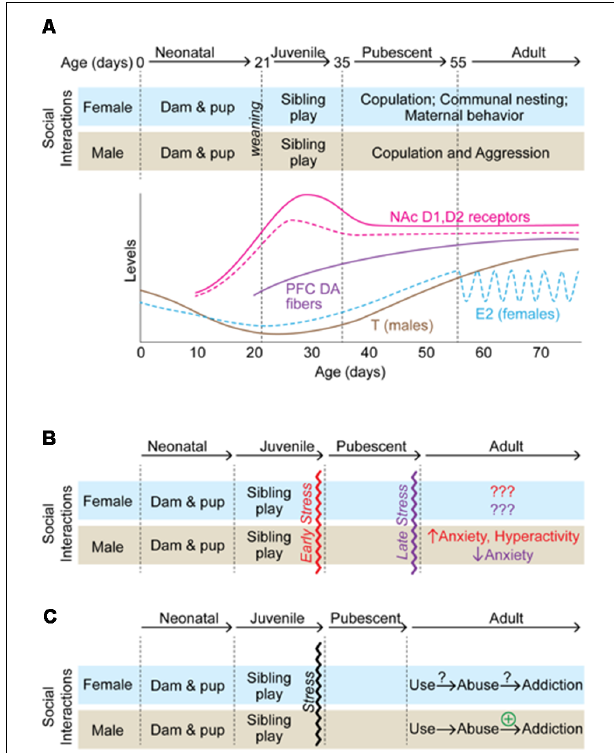
FIGURE 1 | A summary of how adolescent isolation rearing alters behavioral outcomes in male and female rodents. (A) A schematic of developmental markers from birth to adulthood in male (solid lines) and female (dashed lines) rodents. Social interactions/behaviors are indicated at each development milestone and correspond to changes in gonadal hormones and changes within the dopamine (DA) system. (B) Effects of isolation rearing on anxiety-related behaviors. In males, stress early in adolescence has opposite effects on anxiety-related behaviors than late adolescent isolation. (C) Effects of isolation rearing on addiction-related behaviors. While little information is available regarding how adolescent isolation rearing affects females, it increases addiction-related behaviors in